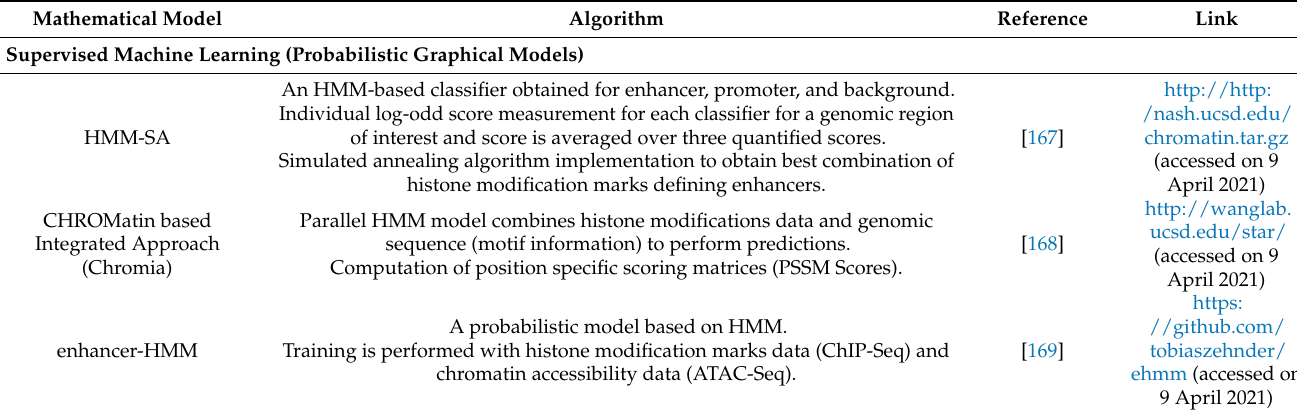
Table 2. In-Silico Algorithms for Enhancer